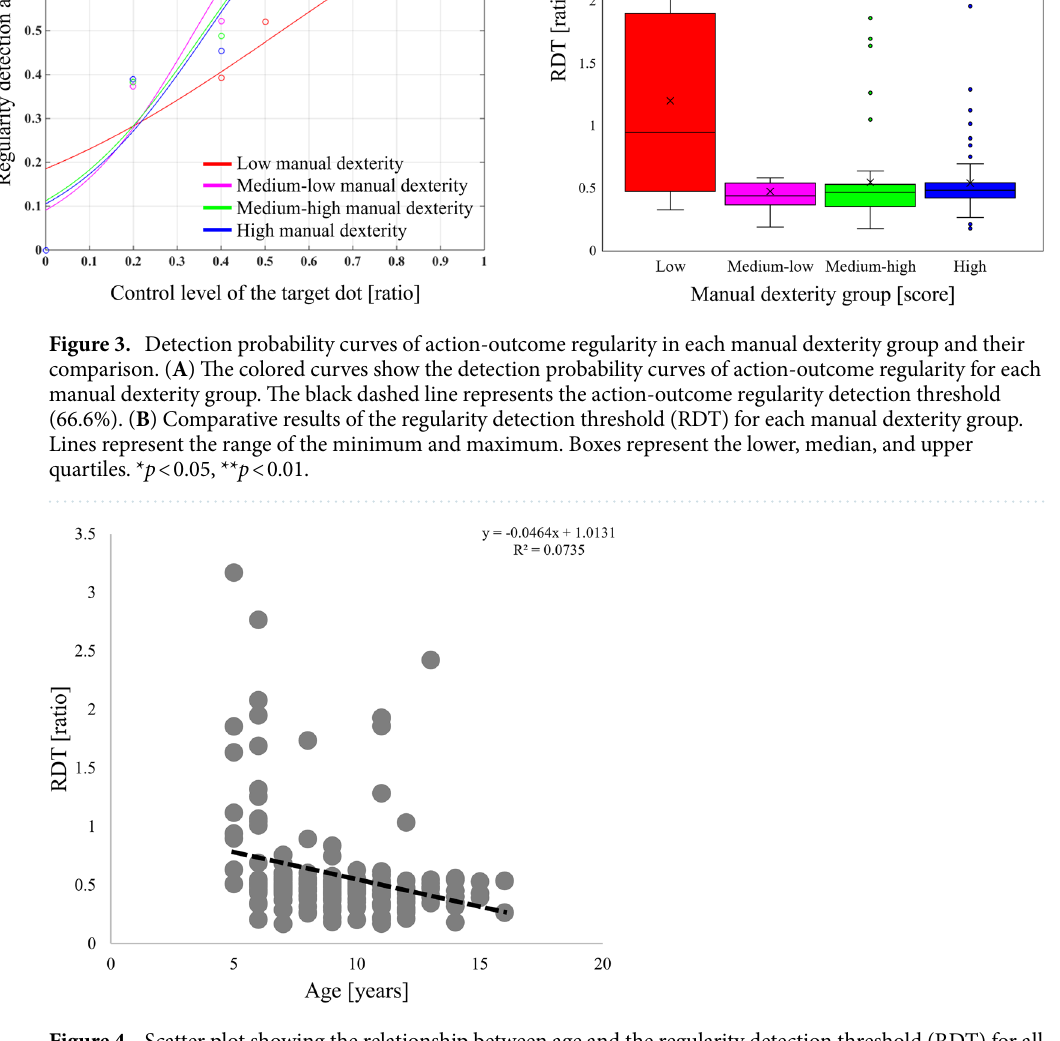
Figure 4. Scatter plot showing the relationship between age and the regularity detection threshold (RDT) for all participating children ( n =